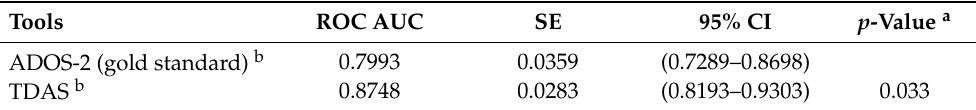
Table 2. Comparison of the ROC AUCs of the ADOS-2 and TDAS scores according to the DSM-5 ASD criteria (N = 156).